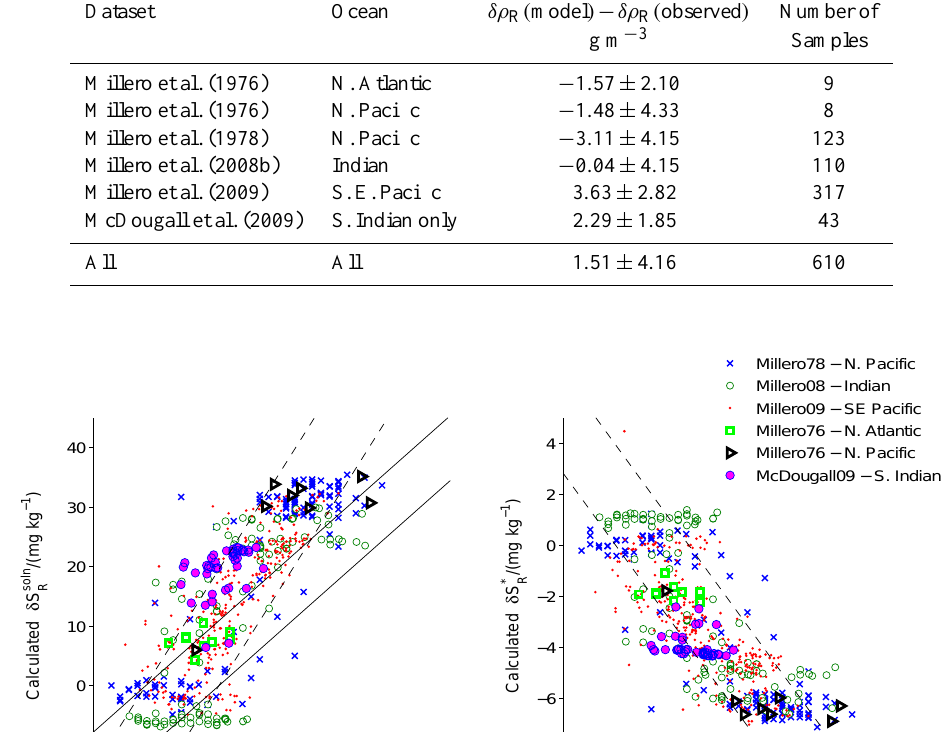
Table 7. Comparison between model-generated and observed estimates of δS dens